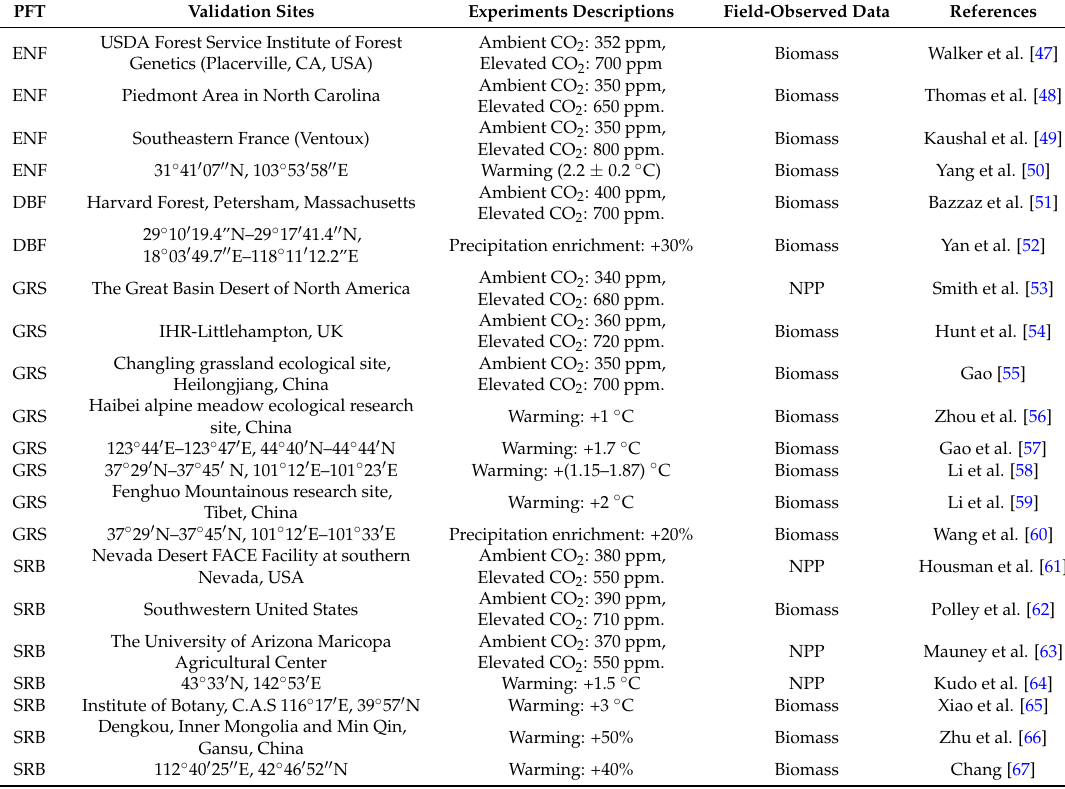
Table 2. List of climate-control experiments for model evaluation in terms of the climate and atmospheric CO 2 effects on NPP. DBF: deciduous broadleaf forest; ENF: evergreen needleleaf forest; GRS: grassland; SRB: